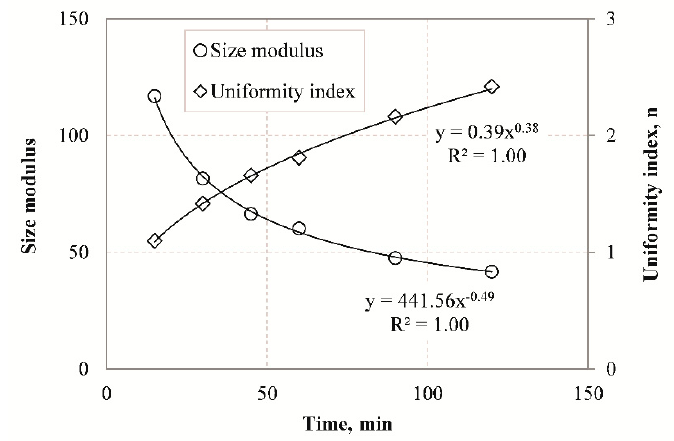
Figure 7. Size modulus and uniformity index versus grinding time using the RR model.